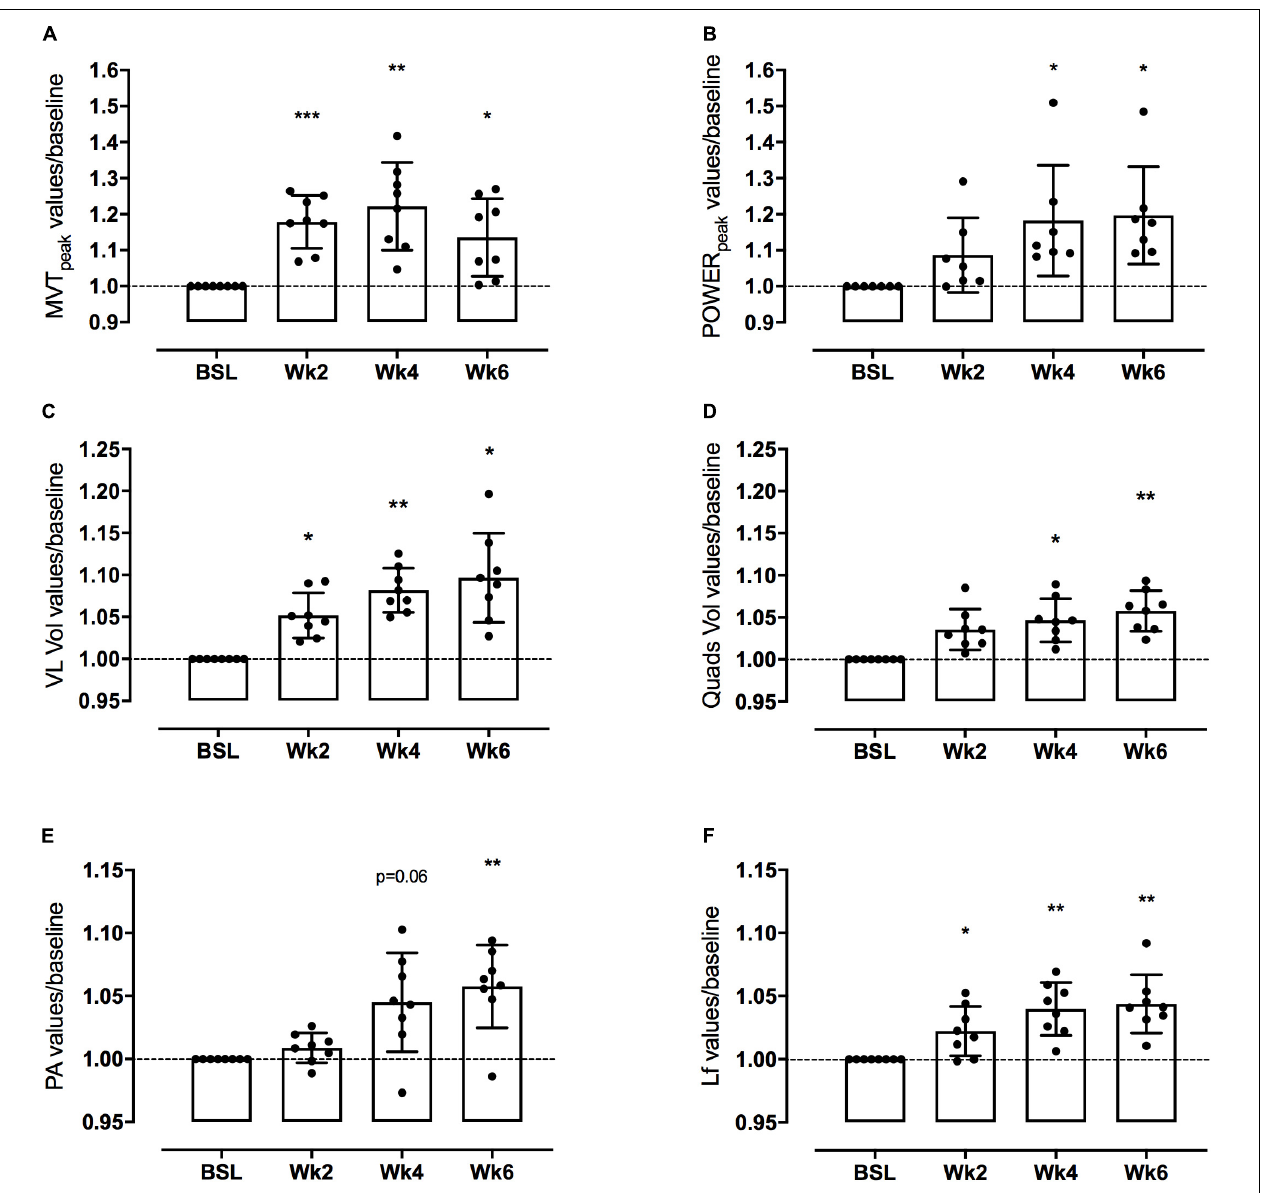
FIGURE 3 | Knee extensor maximum voluntary torque (MVT) and leg extensor power (LEP) ( A,B , respectively), Vsatus Lateralis (VL) and quadriceps (QF) volume ( C,D , respectively), Vastus Lateralis (VL) Pennation Angle (PA) and Length of fascicles (Lf) ( E,F , respectively) adaptations to a 6-week PLT measured after 2, 4, and 6 weeks. Changes are expressed in percentage vs. baseline ( (cid:49) %). Results are normalized for baseline values and shown as Means with scattered plots ± SD. * p < 0.05, ** p < 0.01, *** p <